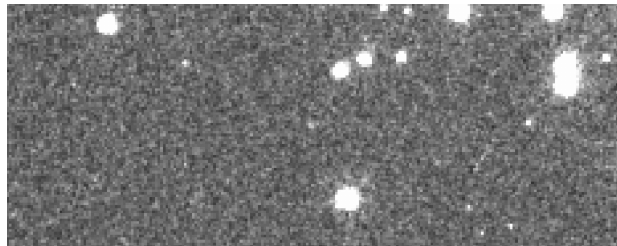
Fig. 6.— Zoom in on the WFPC2 image of Westerlund 2. Image credit: NASA, ESA working with digital images means working with pixels, and with the brightness value associated with each pixel. Pixel positions are described by a pair of (integer) co- ordinates for each pixel. A schematic example is shown in figure 7. Figure 6: Zoom in on the WFPC2 image of Westerlund 2. Image credit: NASA, ESA